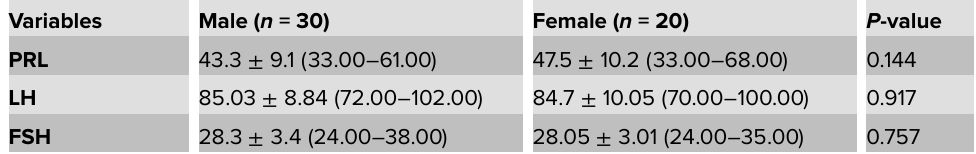
TABLE 2: The (mean ± SD) of serum PRL, LH and FSH among gender in chronic renal failure.